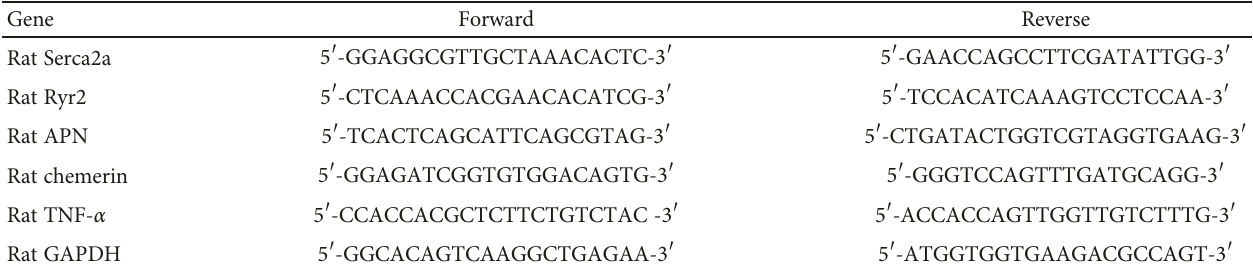
Table 1: The sequences of the abovementioned